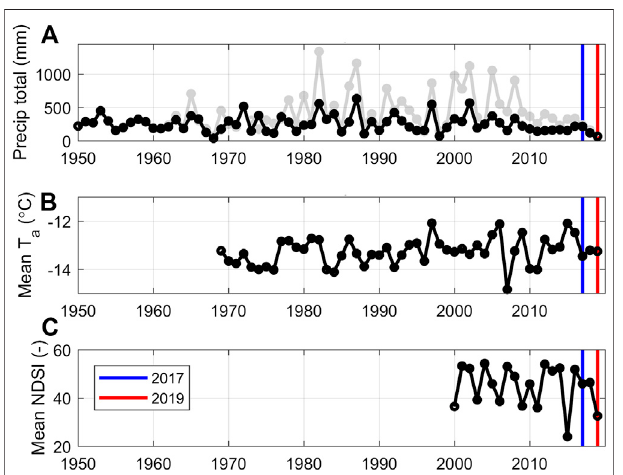
FIGURE 4 | The winter meteorological conditions preceding the acquisitiondatesofPléiadesin2017and2019(verticalgreenbars).Theupper panels for each year show the daily catchment-average fractional snow cover area (fSCA) using a 0.2 threshold of the normalised differential snow index (NDSI) from MODIS MOD10A1 V6 (blue diamonds) and the 5-days average wind speed (m s-1) and direction (arrows) derived from ERA5. The bottom panel for each year shows the cumulative precipitation (mm) record at Yeso Embalse automatic weather station (AWS) (blue line) and hourly temperature ( ° C) from Termas del Plomo AWS (red